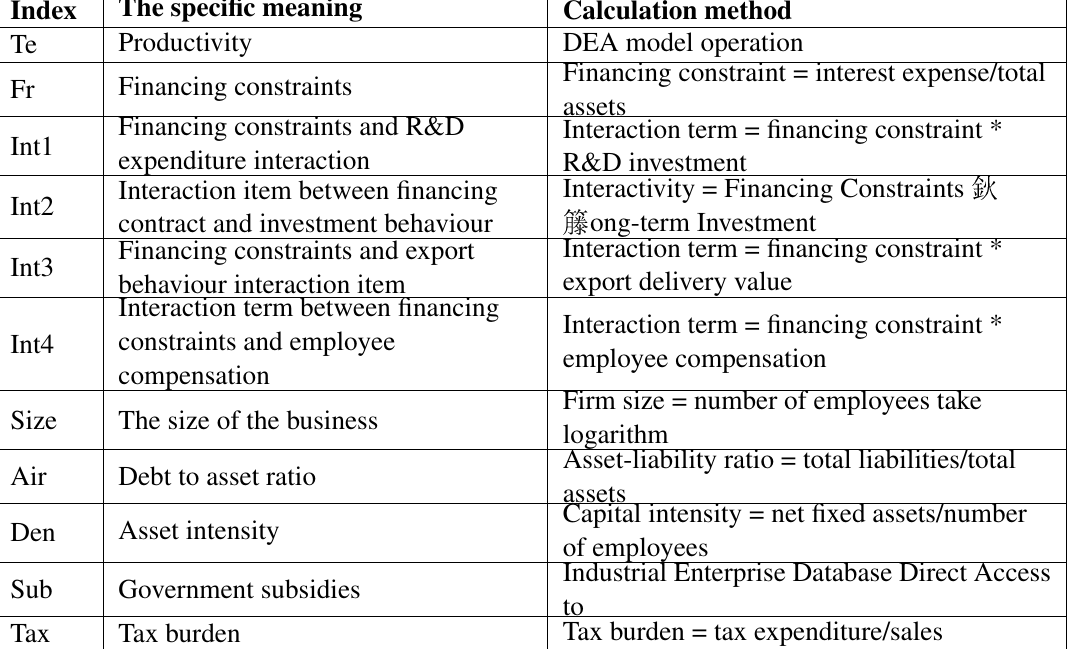
Table 2 Specific indicators and measurement